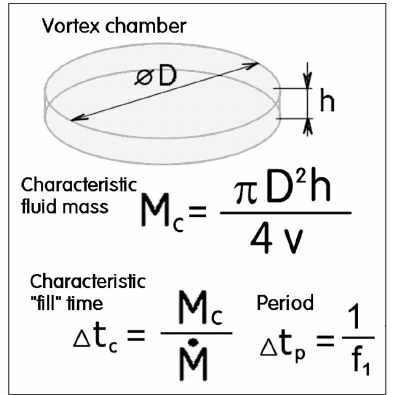
Figure 14. Basic parameters of the author’s elementary theory of vortex-chamber behavior. Both times Equation (3) and (4) are compared for the same particular mass flow rate (note the logarithmic co-ordinates used for plotting) in Figure 15.